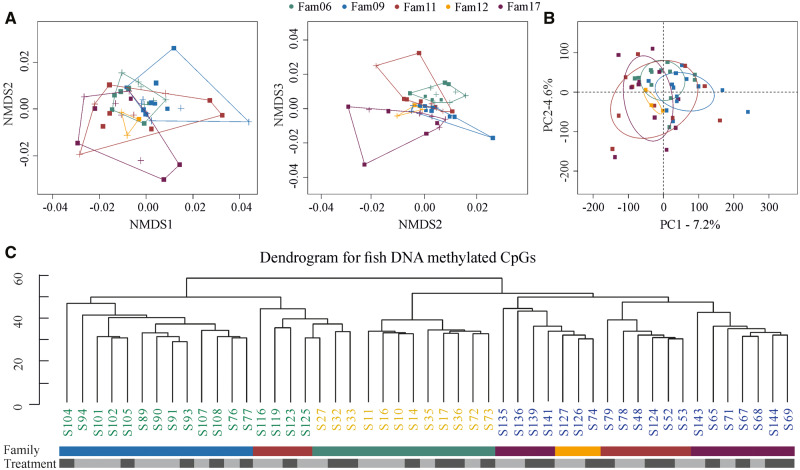
Cluster analyses of individual fish methylomes. (A) NMDS and (B) PCA. Goodness of fit for NMDS suggested the presence of five dimensions with a stress value <0.1. Families are distinguished by different colors. Squares indicate control fish and crosses indicate parasite exposed and infected fish. Ellipses in PCA graph denote the 95% confidence intervals. (C) Hierarchical clustering. k-Mean indicated the presence of three major clades. Within each clade, families are separated from one another. Treatment bar: light gray refers to control and dark gray to infected.